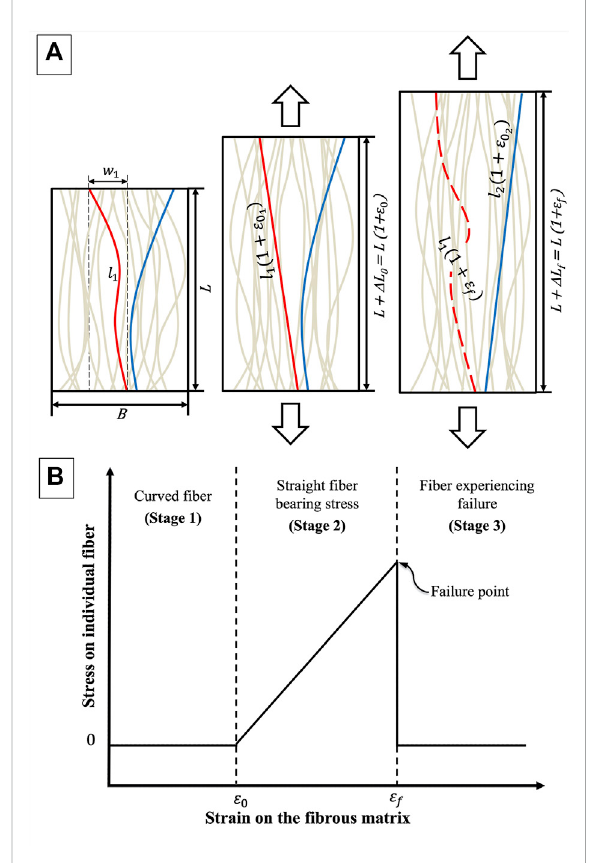
FIGURE 2 Schematic showing tensile load applied on a fi brous material (A) and load – displacement characteristic of a single fi ber (B) . (A, left panel) The fi brous matrix is shown at the beginning of longitudinal stretching when all fi bers are curved, and the material exhibits no mechanical resistance (B, Stage 1). Upon loading (A, central panel), a fi ber (red, solid line) becomes straight and begins to resist deformation, thereby providing mechanical strengthtothematrix(B,Stage2).Asthe fi brousmatrixisstretched to lengthL+ Δ L f ,the fi berbreaks (red, dashedline), stressdrops (B, Stage3)butanew fi ber(solidblueline)straightenstostartresisting the